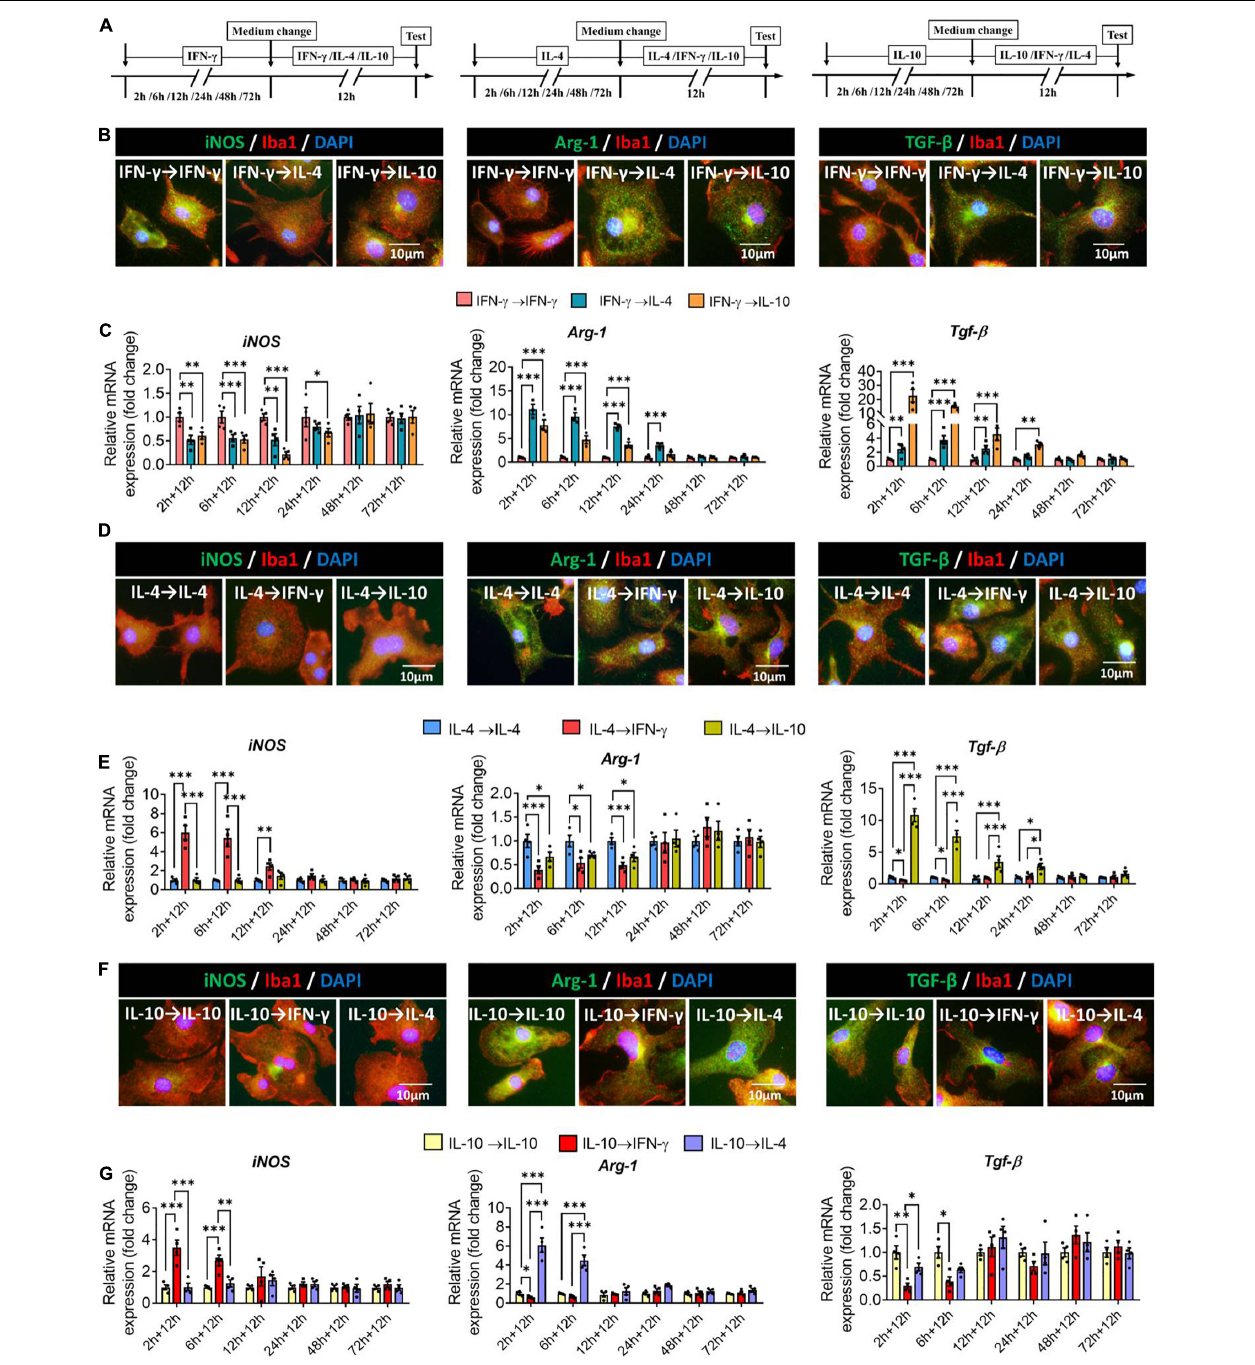
FIGURE 8 | Plasticity of microglial phenotypes based on marker gene expression. (A) Experimental scheme. Microglia underwent primary stimulation with one cytokine for 2–72 h, then the medium was changed and the cells were stimulated with another cytokine for 12 h. Control cells were re-stimulated with the same cytokine as initially. (B) Fluorescence micrographs of primary microglial cultures after they were switched from the primary stimulation to secondary stimulation lasting 12 h. Cells were immunostained against Iba1 (red) and iNOS, Arg-1 or TGF- β (green). (C) Expression of iNOS, Arg-1 and TGF- β in microglia initially stimulated with IFN- γ , then stimulated with another cytokine. (D) Fluorescence micrographs of primary microglial cultures after they were switched from the primary IL-4 stimulation to secondary stimulation with IFN- γ or IL-10 lasting 12 h. Cells were immunostained against Iba1 (red) and iNOS, Arg-1 or TGF- β (green). (E) Expression of iNOS, Arg-1 and TGF- β in microglia initially stimulated with IL-4, then stimulated with another cytokine. (F) Immunocytochemical double-labeling for Iba1 (red) and iNOS, Arg-1 or TGF- β (green) in IL-10-stimulated microglia exposed to IFN- γ or IL-4 for 12 h. Fluorescence micrographs of primary microglial cultures after they were switched from the primary IL-10 stimulation to secondary stimulation with IFN- γ or IL-4 lasting 12 h. Cells were immunostained against Iba1 (red) and iNOS, Arg-1 or TGF- β (green). (G) Expression of iNOS, Arg-1, and TGF- β in microglia initially stimulated with IL-10, then stimulated with another cytokine. Data are presented as mean ± SEM ( n = 4 well per group, three replicates per sample), ∗ P < 0.05, ∗∗ P < 0.01, ∗∗∗ P < 0.005 (one-way ANOVA with Tukey’s multiple-comparisons test).